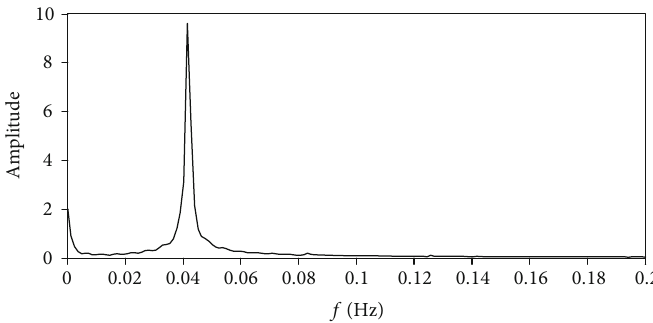
Figure 3: The frequency analysis of the momentum wheel speed.